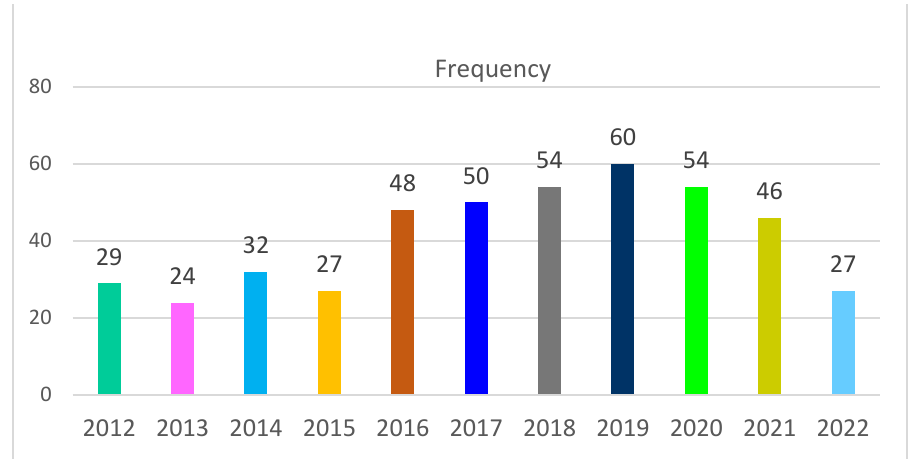
Figure 2. Publication by year (2012 – 2022).